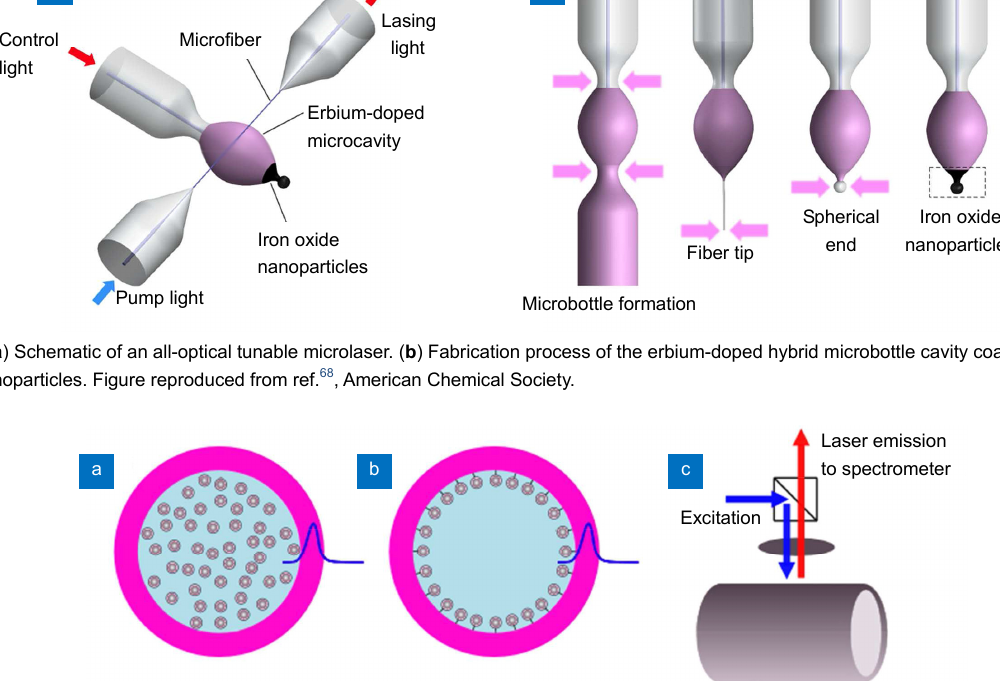
Fig. 7 | Illustrations of aqueous QDs ( a ) in solution inside an OFRR and ( b ) immobilized as a single layer on the inner surface of an OFRR. ( c ) Illustration of the experimental setup using confocal geometry. Figure reproduced from ref. 8 , American Chemical